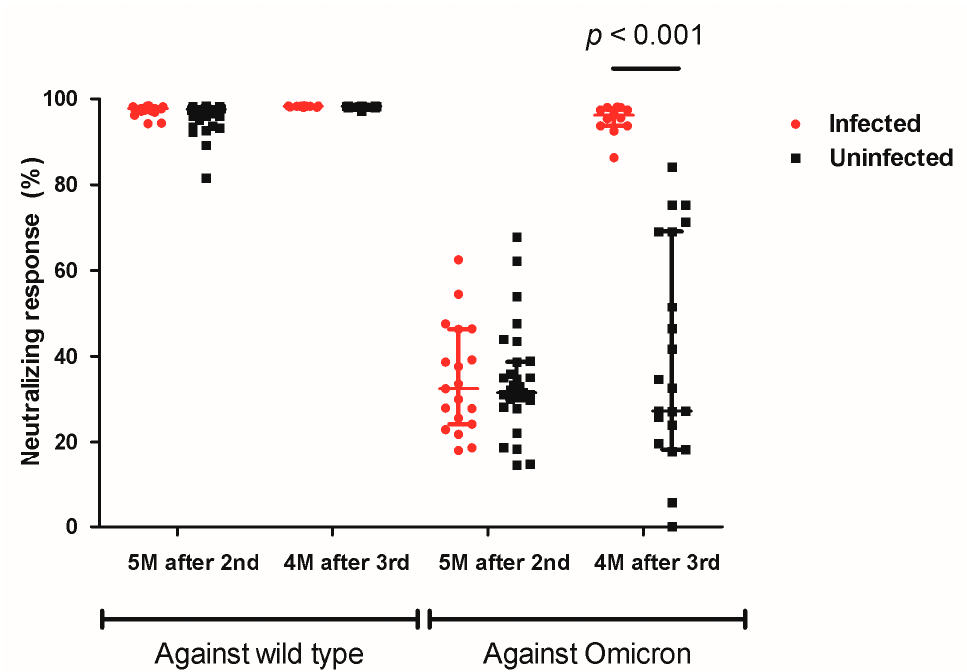
Figure 3. Neutralizing response against the wild-type and Omicron variant in COVID-19-infected and uninfected students.